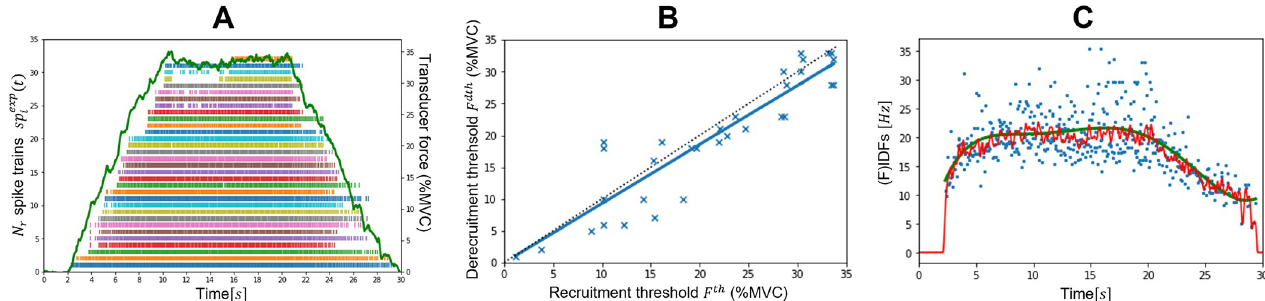
Fig 4. Experimental data obtained from HDEMG signal decomposition in the dataset DTA 35 . (A) Time-histories of the transducer force trace in %MVC (green curve) and of the N = 32 MN spike trains identified from HDEMG decomposition and ranked from bottom to top in the order of increasing force r recruitment thresholds F th . (B) Association between force recruitment and derecruitment threshold, fitted by a linear trendline y = 0.9 � x ( r 2 = 0.85). Identity is displayed as a black dotted line. (C) Time-histories of the MN instantaneous discharge frequencies (IDFs, blue dots) smoothed by convolution with a Hanning window of length 400ms (red curve) and with a sixth-order polynomial trendline (green curve) of the lowest-threshold identified (1 st ) MN.